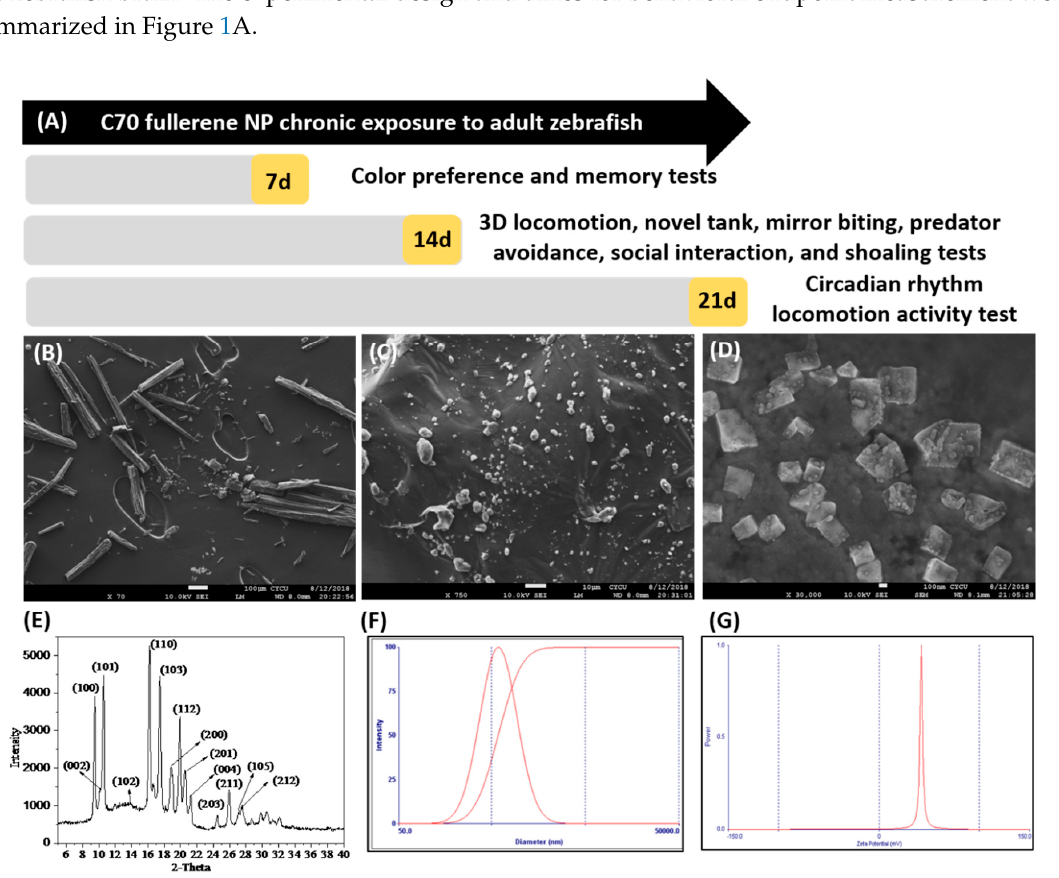
Figure 1. ( A ) Overview of the experimental design and time points for chronic exposure of C 70 fullerene nanoparticles (NPs) to adult zebrafish. For chronic toxicity, we measured color preference and short-term memory at 7 days post-exposure (dpe). 3D locomotion, novel tank, mirror biting, predator avoidance, social interaction, and shoaling tests were given at 14 dpe. The circadian rhythm test was given at 21 dpe. After all behavior tests, fish were dissected and subjected to biochemical assays by 22 dpe. Characterization of the C 70 NPs used in this study: ( B ) SEM micrograph of C 70 NPs stock solution in the absence of solvents, ( C ) C 70 NPs dissolved in DMSO showing wide disparity in aggregation, ( D ) high magnification scanning electron micrograph showing the size of C 70 NPs used in this study, and ( E ) X-ray diffraction patterns of the crystal quality of the C 70 NPs. ( F ) The particle size distribution of 0.5 ppm C 70 NPs in DMSO was measured by dynamic light scattering. C 70 NP suspensions were sonicated prior to measurement to resuspend the large particles and assess changes in large aggregate status. ( G ) The zeta potential value of C 70 NPs is estimated at − 34.0 mV.